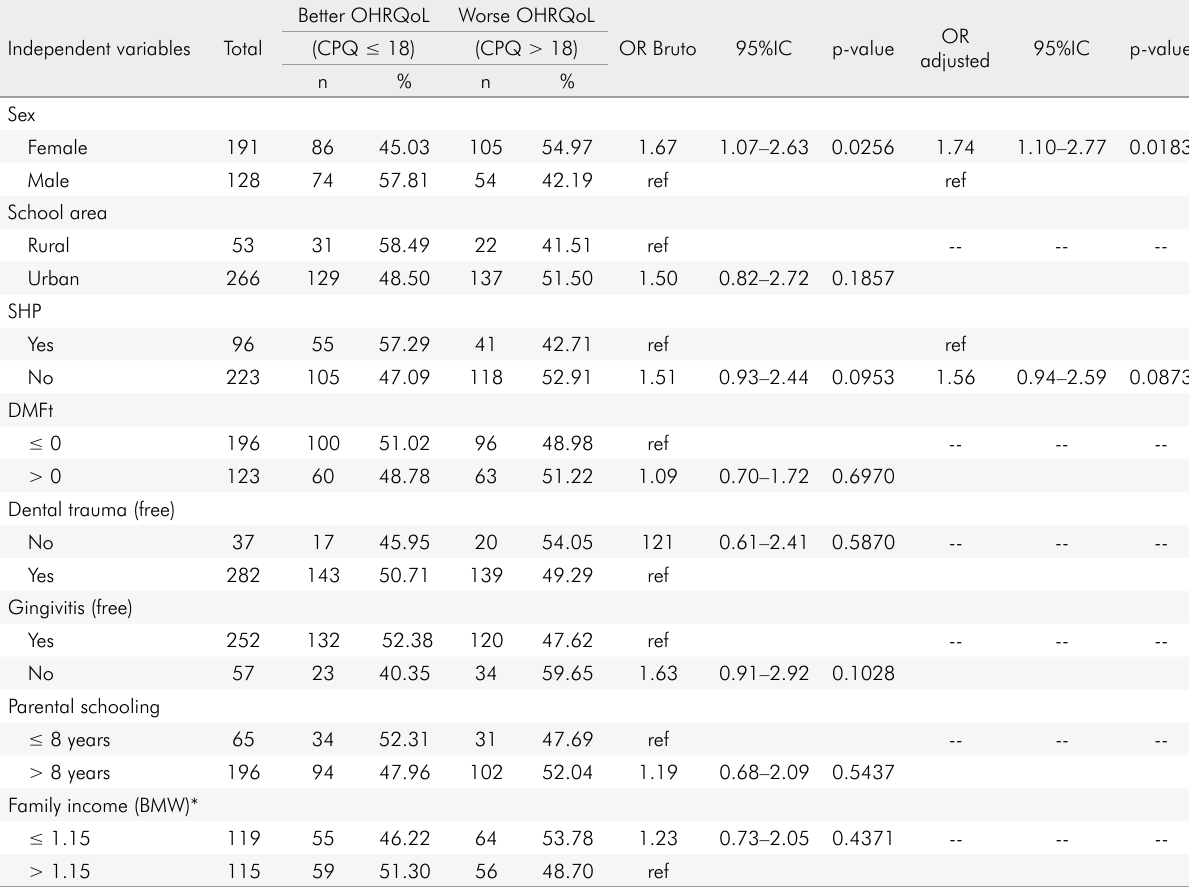
Table 4. Crude and adjusted analyzes of CPQ SHP access variables of Nova de Friburgo, RJ, Brazil,